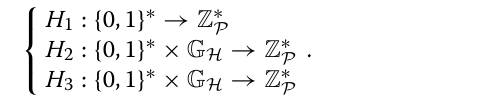
stored in the cloud medical database, where only CA and LEA have access